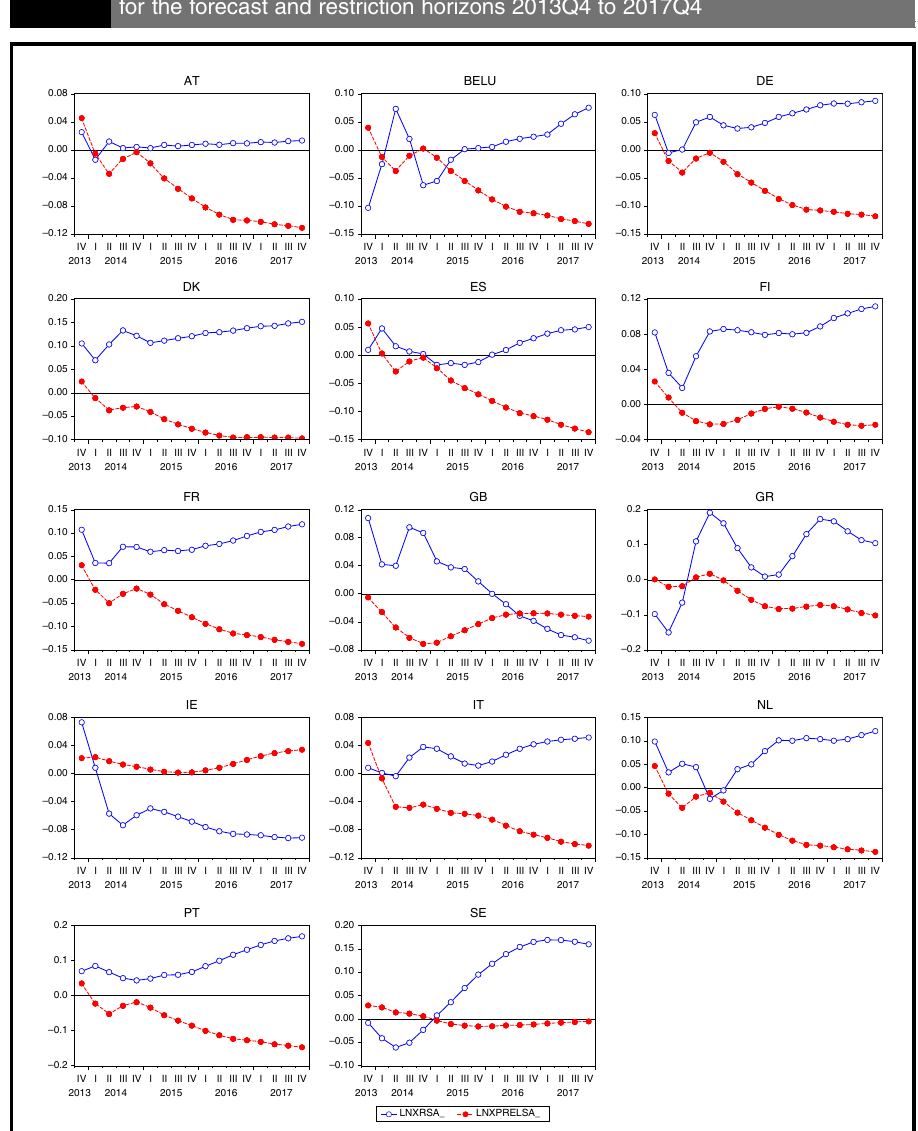
Figure 2 Conditional forecasts of real tourism exports (LNXRSA; solid lines) and relative tourism export prices (LNXPRELSA; dashed lines) per EU-15 member country for the forecast and restriction horizons 2013Q4 to